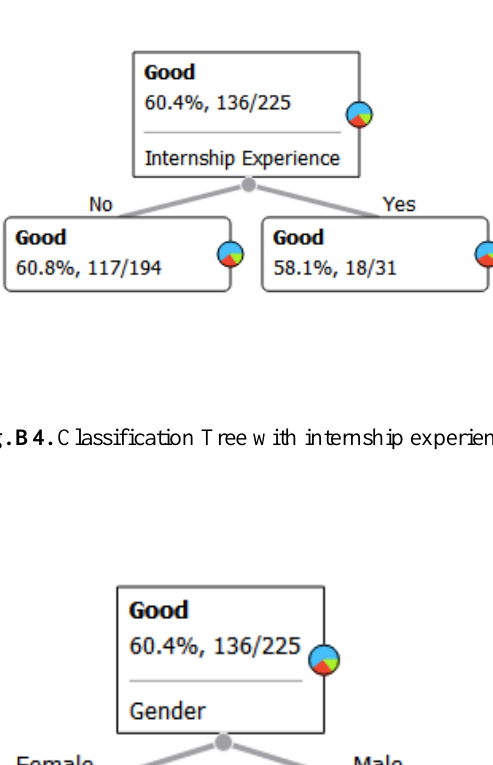
Fig. B3. Classification Tree with family demography